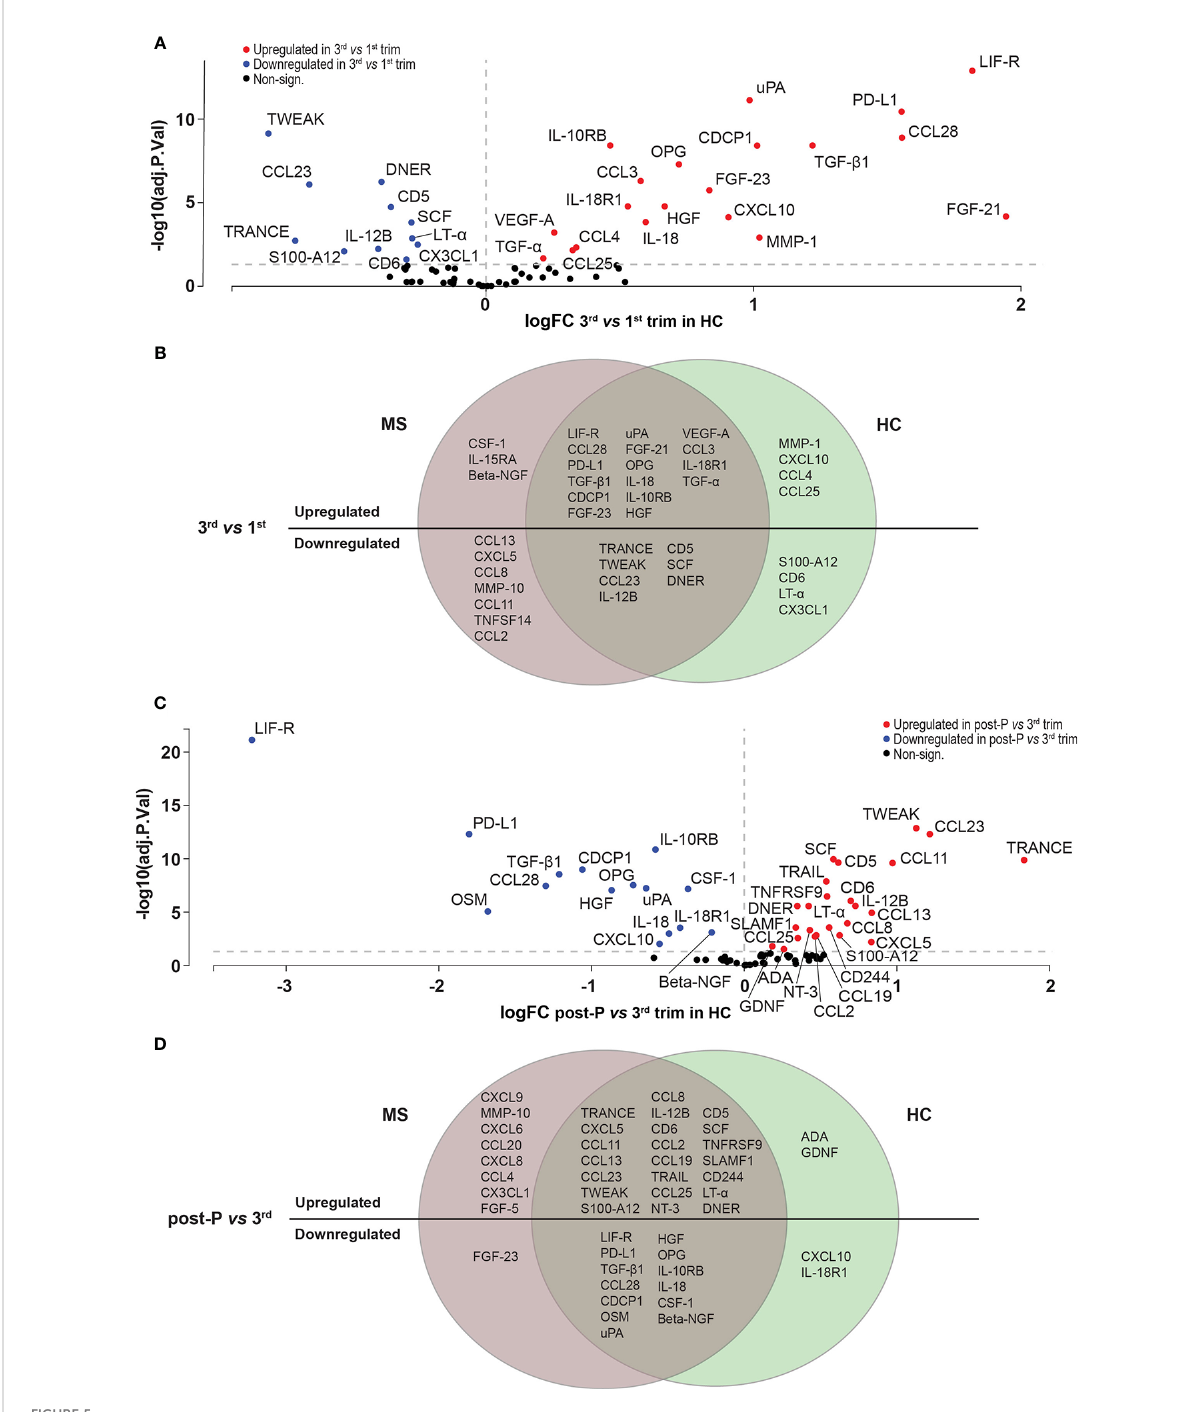
FIGURE 5 Differentially expressed proteins in HC. (A) Volcano plot showing the differentially expressed proteins (DEPs) at 3 rd trimester versus 1 st in healthy controls (HC, n = 10). DEPs were determined using linear models and Benjamini-Hochberg correction for multiple comparisons (FDR<0.05). Up-and downregulated DEPs are shown as red and blue, respectively. Non-signi fi cant proteins are shown in black. (B) Venn diagram of the overlapping and unique up-and downregulated DEPs between MS (n=15) and HC (n=10) at 3 rd trimester versus 1 st . (C) Volcano plot showing the differentially expressed proteins (DEPs) post-P compared to 3 rd trimester in HC. (D) Venn diagram of the common and unique up- and downregulated DEPs between MS (n=15) and HC (n = 10) at post-partum versus 3 rd trimester. HC, healthy controls; logFC, logFoldChange; MS, multiple sclerosis; post-P, post-partum; trim,